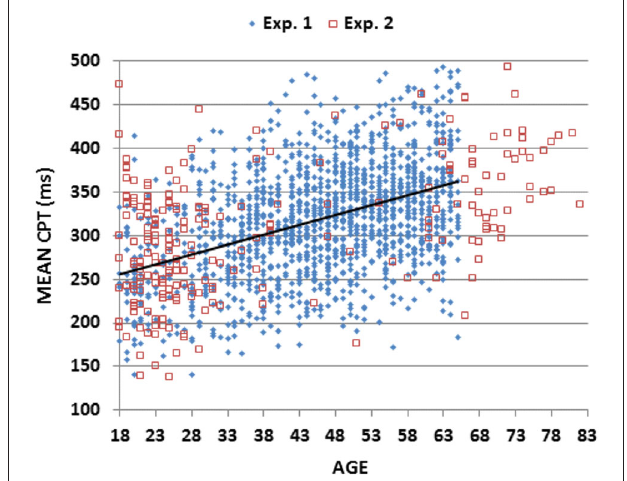
FIGURE 5 | Mean central processing time (CPT) . CPTs were derived by subtracting RT latencies in a simple reaction time (SRT) task from CRT latencies averaged over different stimuli for subjects of different ages in Experiments 1 and 2. Linear fit is shown for Experiment 1